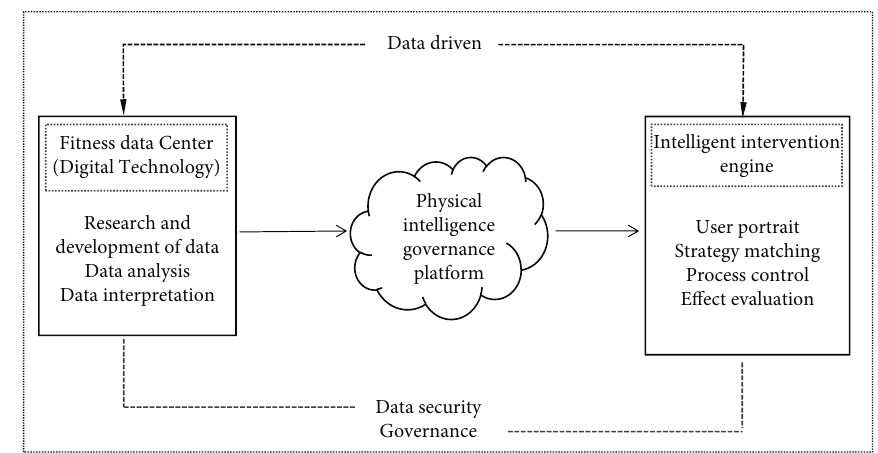
Figure 7: Implementation framework of data-driven intelligent governance of college students’ physical